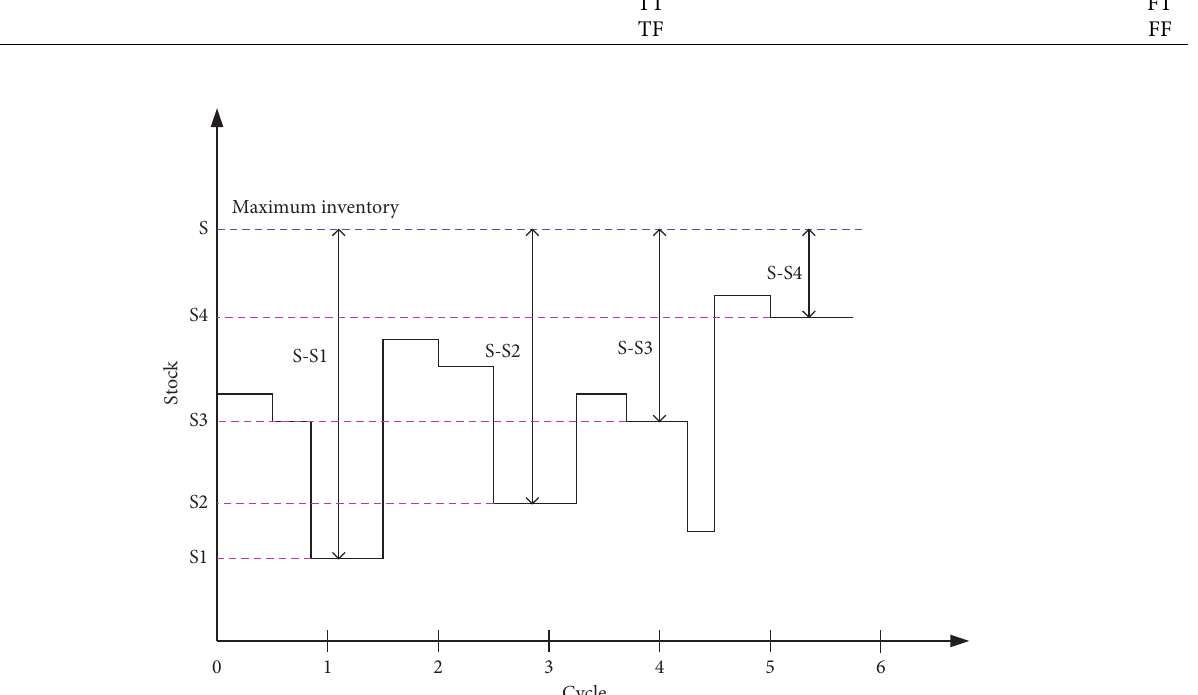
Figure 6: Schematic diagram of changes in replenishment of agricultural products over